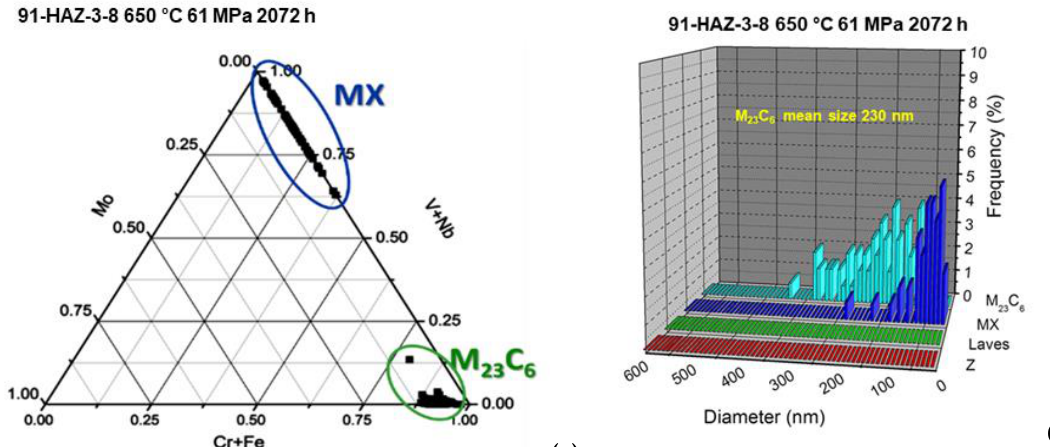
Figure 11. Failed crept cross-weld specimen 91-HAZ-3-8 650 °C 61 MPa 2072 h (sample D), ternary diagram ( a ) and size distribution ( b ) (TEM analysis).